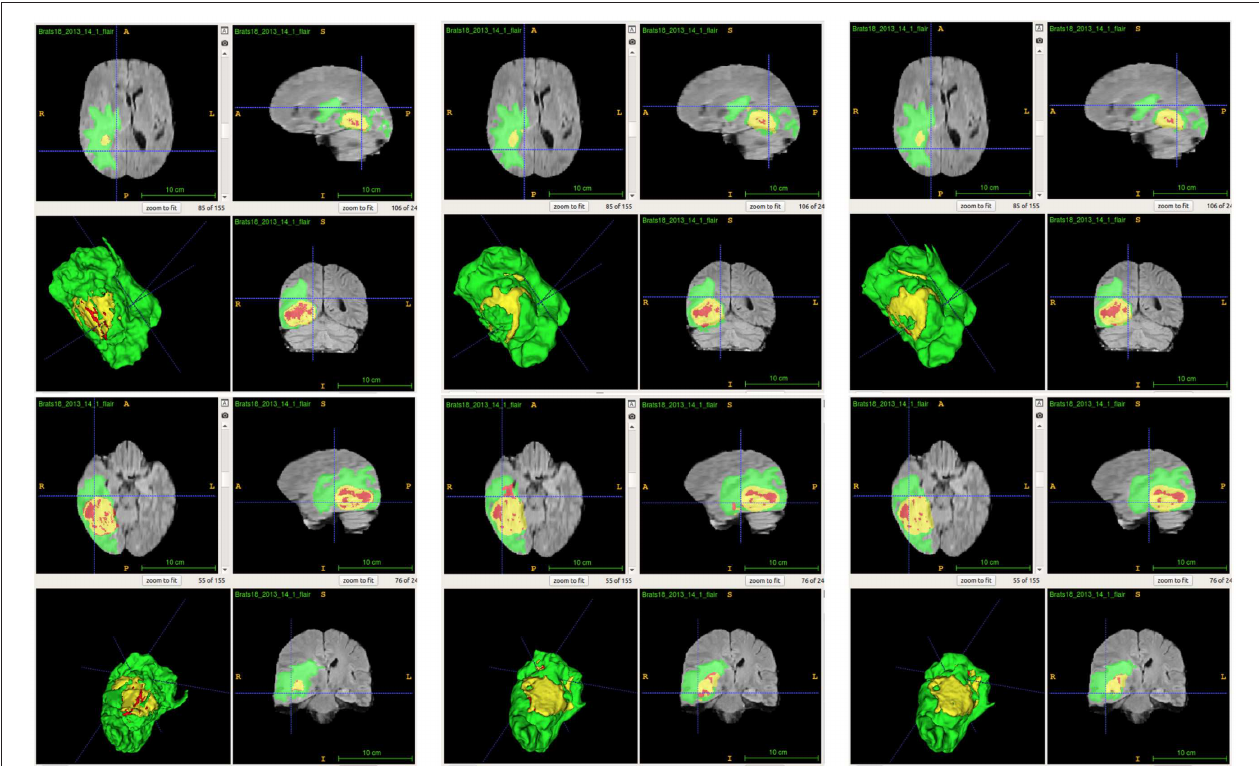
FIGURE 9 | Examples of predictions from ensemble with different inputs. Top row shows the predictions from ensemble of DeepMedics, and bottom row shows the predictions from ensemble of 3D U-Nets (from left to right: ground-truth lesions, prediction from ensemble, and prediction from ensemble with additional brain parcellation masks.) Red: enhancing tumor, yellow: necrosis & non-enhancing tumor, and green: edema. ITK-SNAP (Fedorov et al., 2012) is used to visualize the MR images and lesion masks.